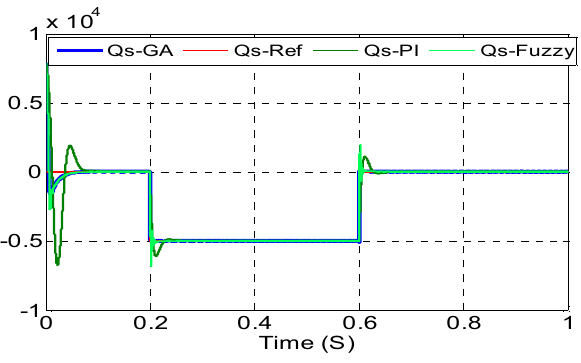
Figure 23. Reactive power stator